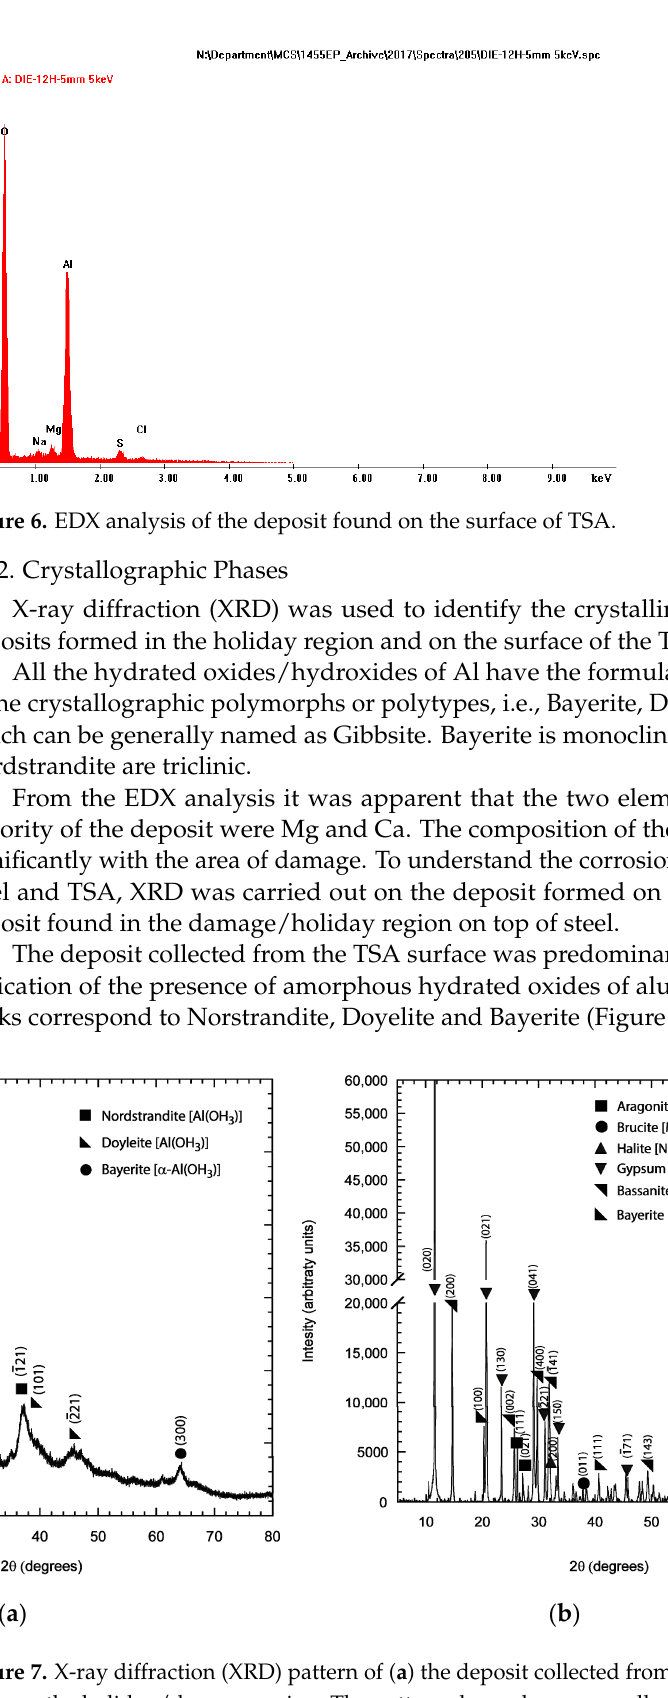
( f ) Figure 5. SEM micrographs of the cross ‐ section of TSA specimen with one holiday (18.3% area) ( a ), ( d ); showing EDX patterns of regions 1 ( b ), 2 ( c ) and A1 ( e ) and A2 ( f ). A thin deposit (~10 μ m) was also seen on top of the thermal spray layer (Figure 5d). This was seen in all specimens (irrespective of the damage size or area). The deposit on top of the thermal spray Al layer had multiple layers. The layer closest to Al had Al and O, the layer above to it had Mg and O in addition to Al (Figure 5e,f).